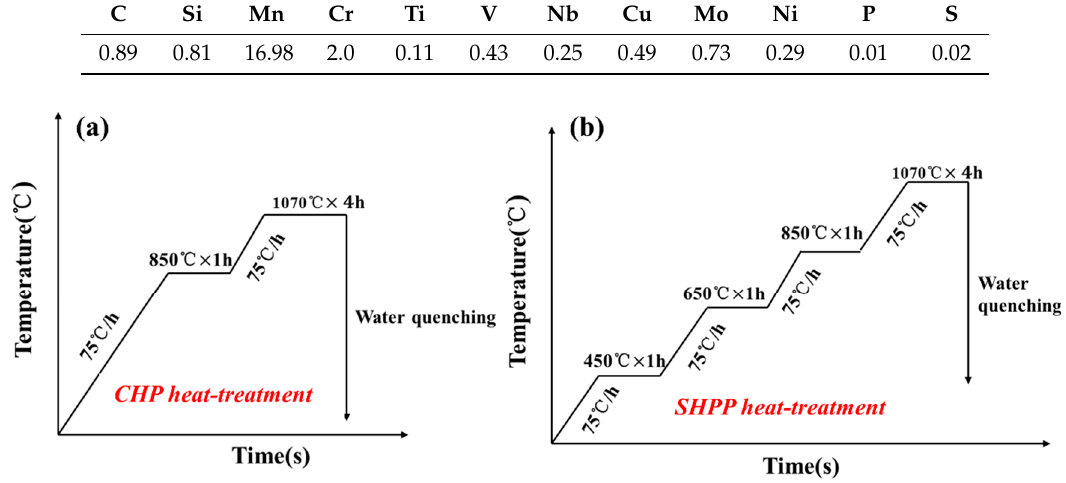
Figure 2. Heat-treatment curve of continuous heating process (CHP) ( a ) and segmented heat preservation process (SHPP) ( b ) of steel.